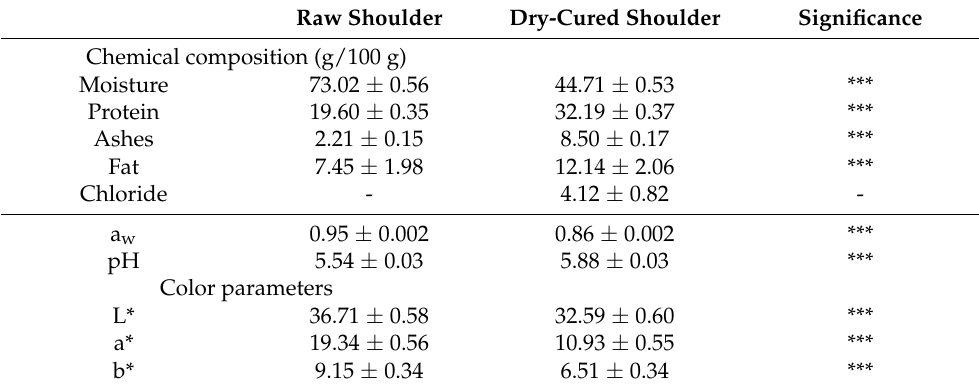
Table 1. Chemical composition and physicochemical characteristic (mean ± standard error) of raw and dry-cured B í saro